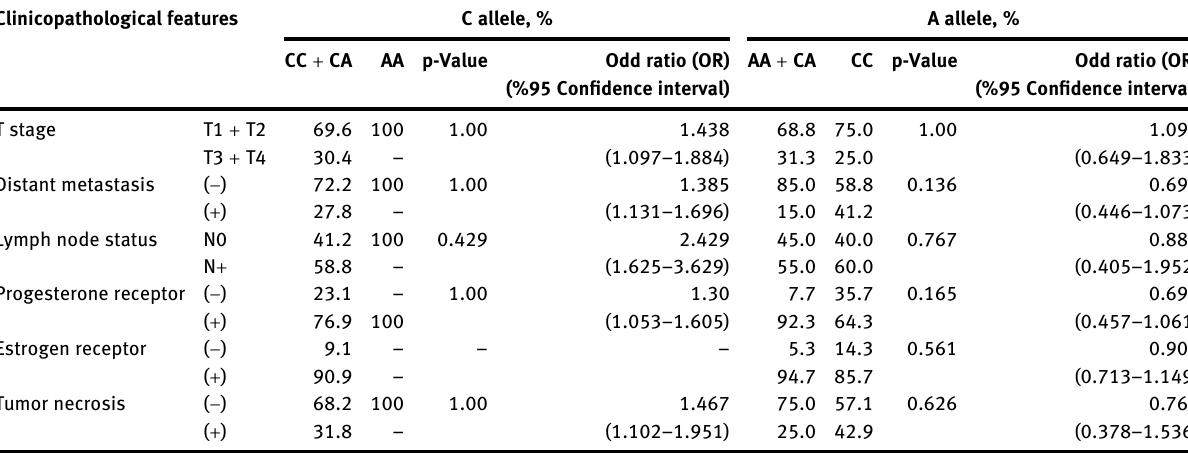
Table  : Association of PIK  CA C>A polymorphism with clinicopathological features of BC. Clinicopathological features